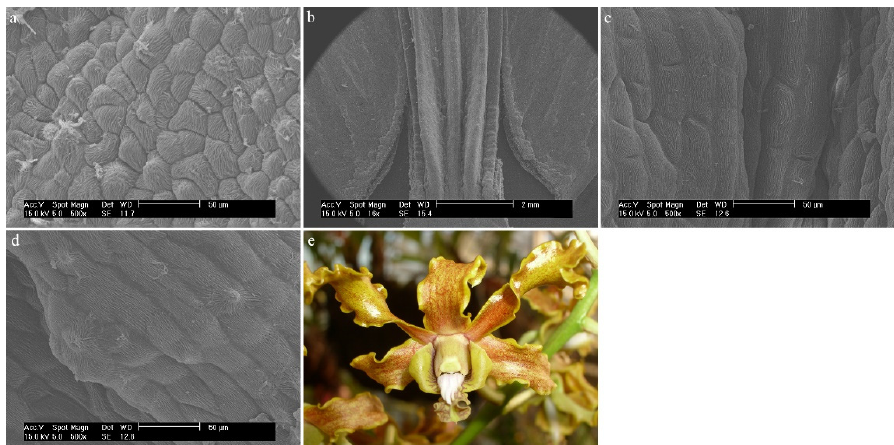
Figure 20. Dendrobium discolor Lindl.: ( a ) the epichile part of the labellum; ( b ) the hypochile and the mesochile part of the labellum; ( c ) the hypochile part of the labellum; ( d ) papillae of the hypochile part of the labellum; ( e ) flower (photo by John Varigos).